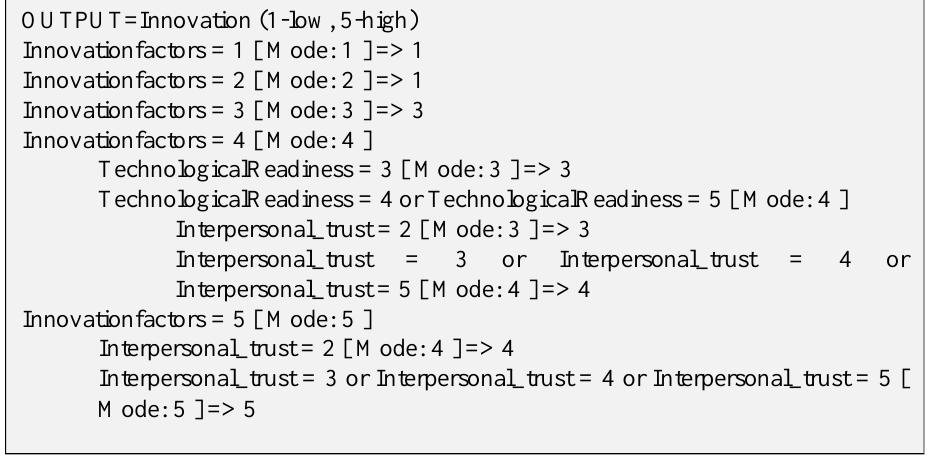
Figure 1 Decision tree model for Innovation driving factors